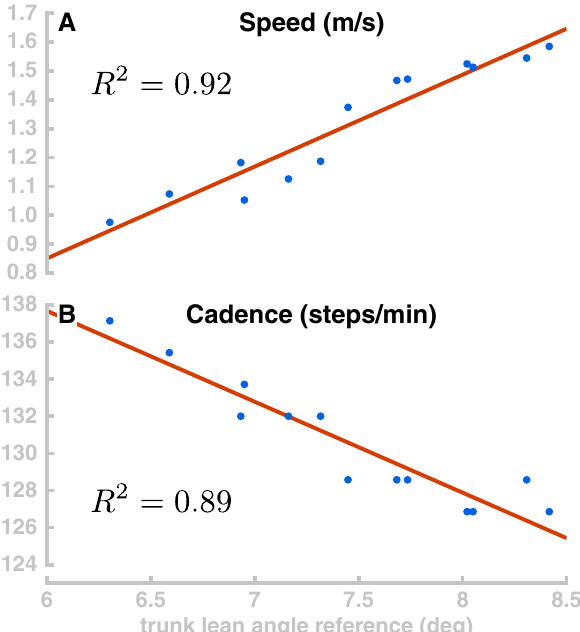
Figure 7. Velocity and cadence control. Panel ( A ) shows the relationship between the reference parameter for trunk lean and the resulting movement speed for 13 movements (blue dots) and the linear fit (red line). Panel ( B ) shows the effect of the trunk lean change on the walking